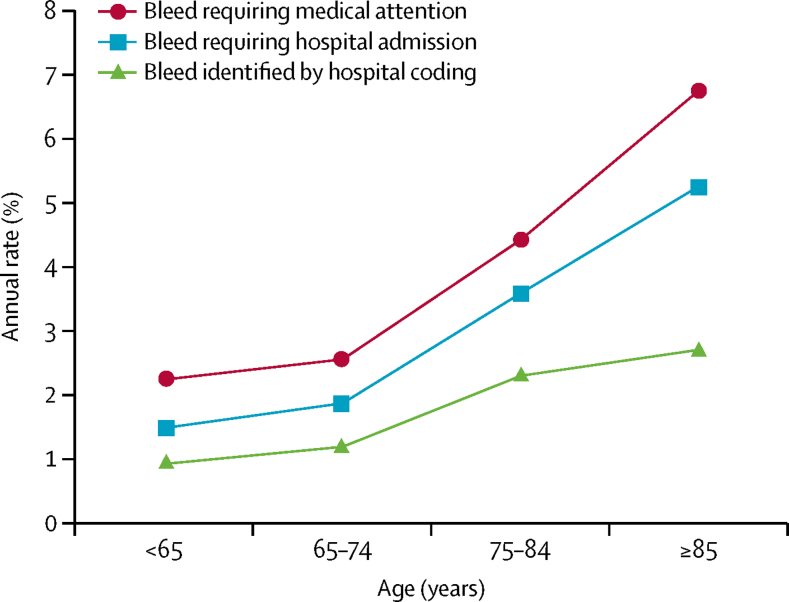
Annual rates of bleeding events requiring medical attention according to source of dataAscertainment in the Oxford Vascular Study, with multiple sources versus bleeding events identified by use of administrative hospital coding alone. Age-specific reasons for major bleeds that were not identified by administrative coding alone are reported in table 2.